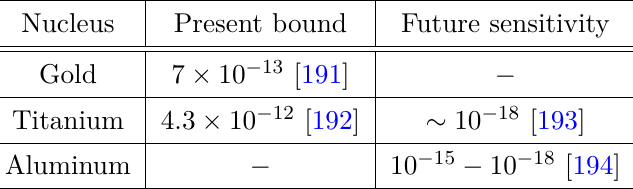
Table 4 . Current experimental bounds on the BR ( µ − e ) conv. in the nuclei. Future sensitivities are presented on the last